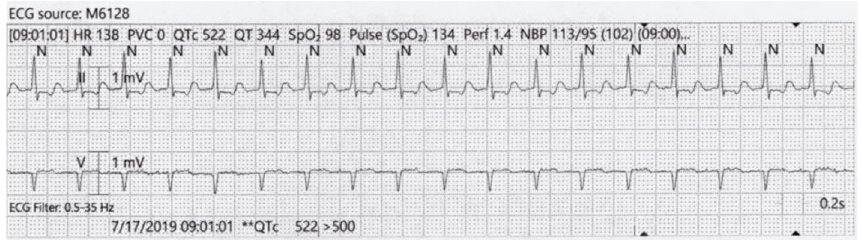
Figure 2: Patient ’ s rhythm strip showing no improvement in response to adenosine.